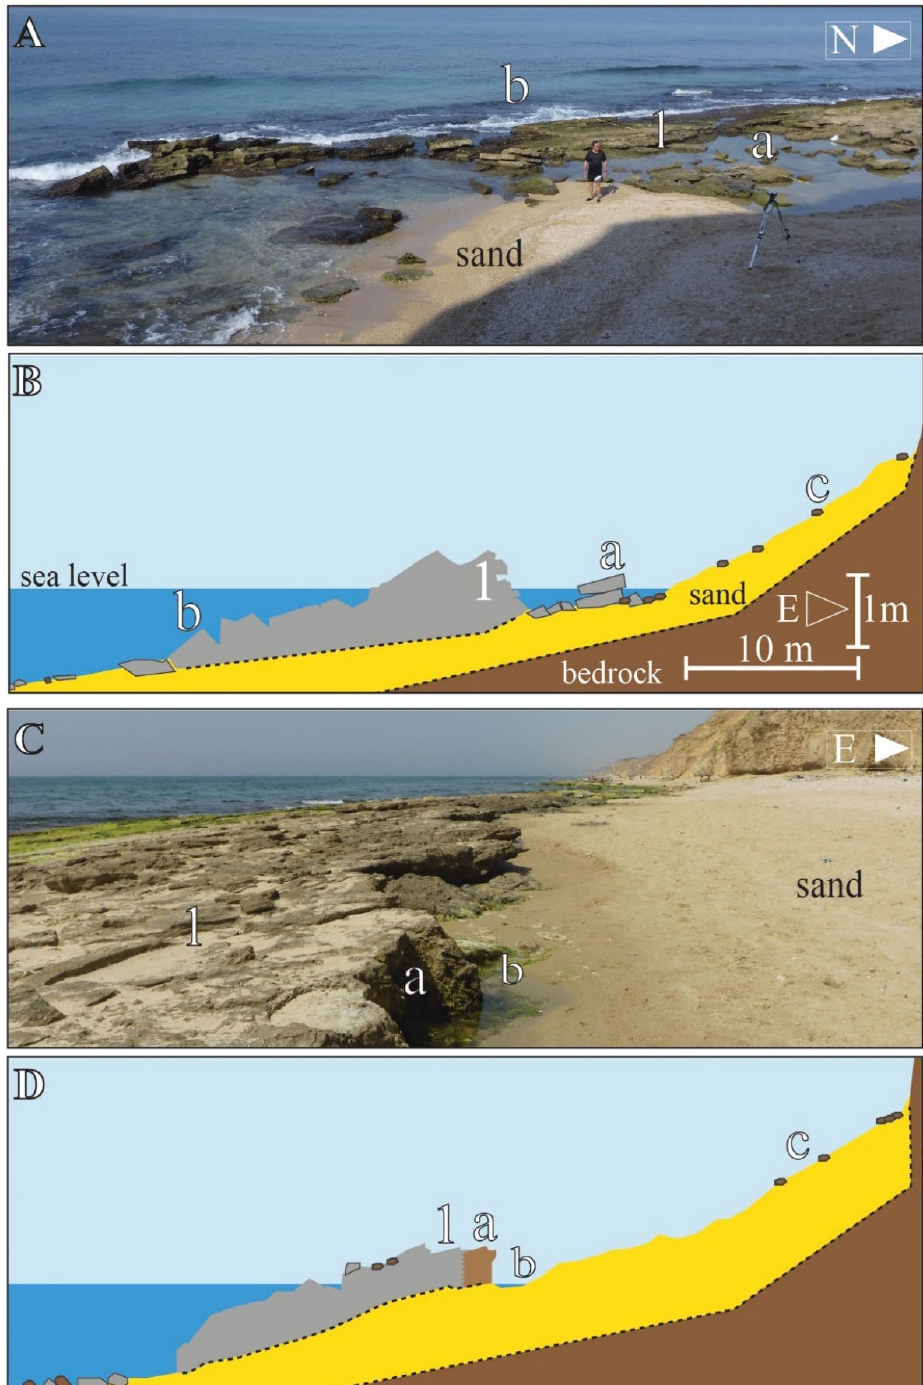
(Figure 5E,F), the BR section meets an elongated kurkar block at its land-facing front. The combined structure creates a sediment spit abutting the micro-cliff.